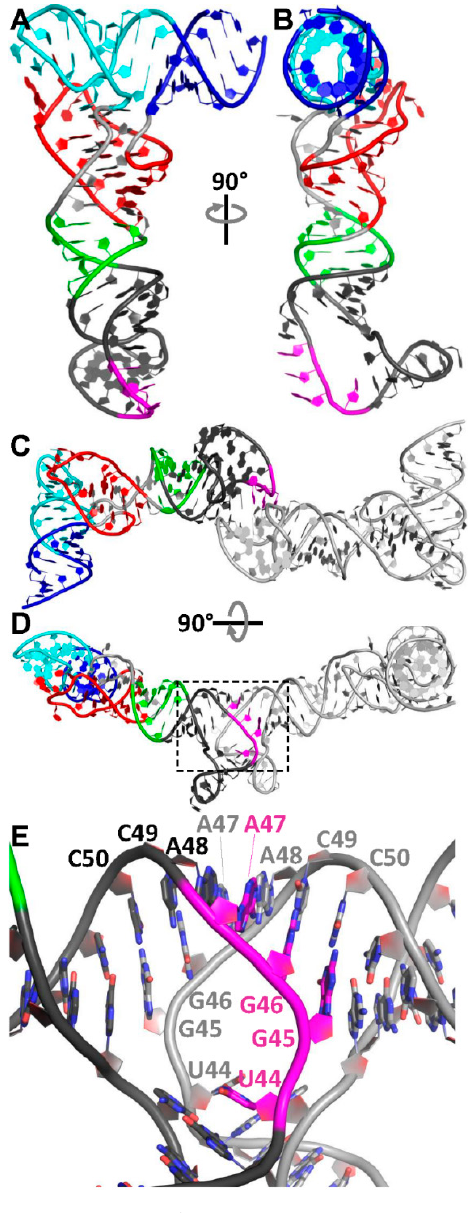
Figure 5. The 3.0 Å resolution crystal structures of tRNA–antiterminator Construct #19 in space group C 222 1 . ( A ) Cartoon representation of the overall structure. ( B ) Part A rotated 90°. ( C ) Overall structure of crystal packing at the antiterminator bulge. ( D ) Part C rotate 90°. ( E ) Close-up of the antiterminator bulge interactions highlighted by the dashed box in Panel D. Nucleotide numbering corresponds to numbering in the full-length construct. Coloring as in Figure 1 schematic.